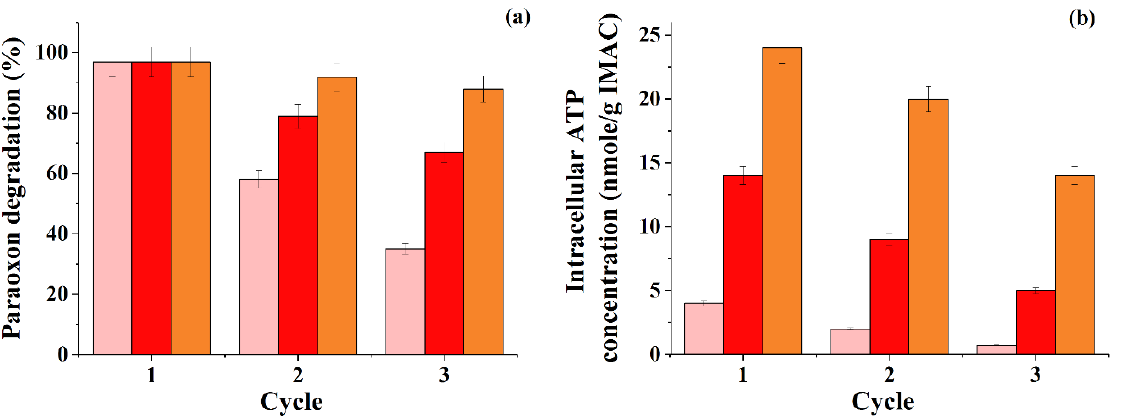
Figure 2. Multiple uses of IMAC in the paraoxon degradation (0.15 mm): ( a ) IMAC with cell concentrations of ( ◼ 10% w / w ), ( ◼ 20% w / w ), and ( ◼ 30% w / w ) and ( b ) changes in intracellular ATP concentration in repeatedly used samples of IMAC during paraoxon degradation.